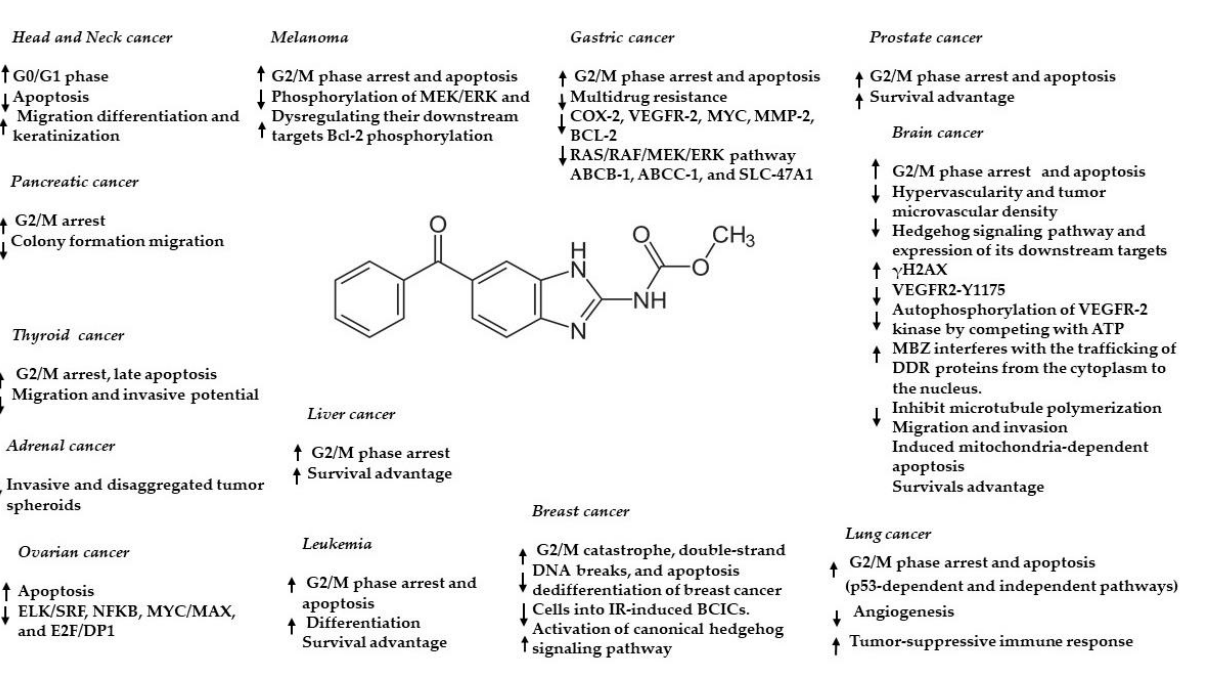
Figure 3. Anticancer effects and mechanisms of action of MBZ in different cancers. ↑ upregula- tion/activation; ↓ downregulation/inhibition. Table 3. The most relevant molecular properties of MBZ in preclinical